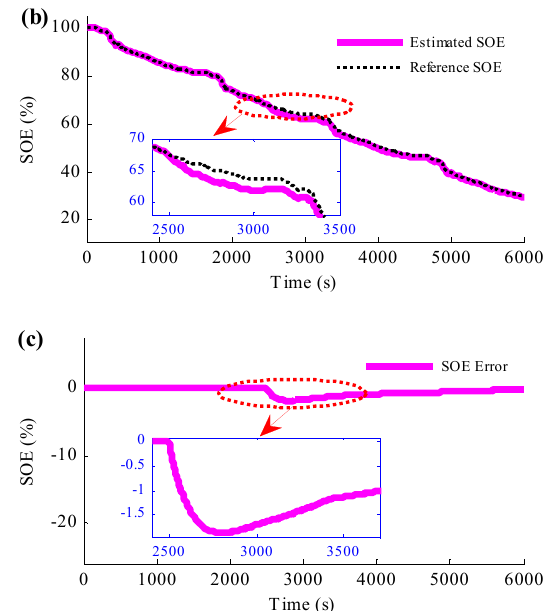
Figure 7. Simulation results when the method to simultaneously detect the current sensor fault and estimate the SOE is applied: ( a ) comparison between the estimated current fault and the reference current fault; ( b ) the SOE estimation results; ( c ) SOE estimation error.